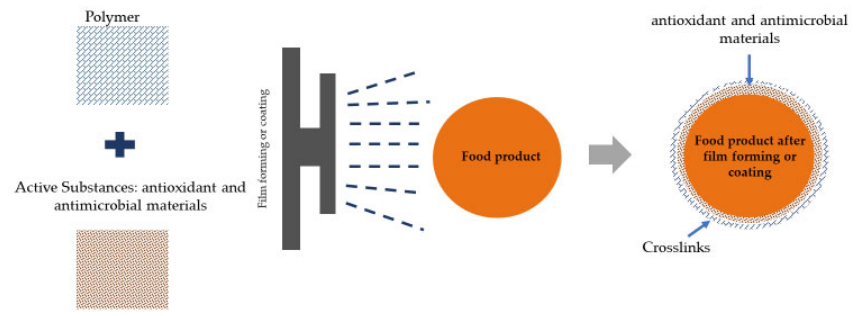
Figure 1. The system functions of a polymeric matrix, recreated from Munteanu and Vasile [37].